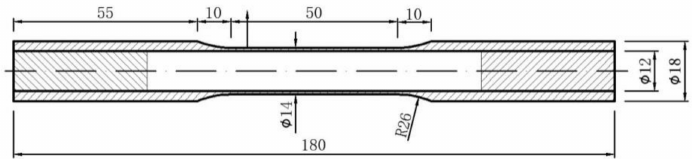
Figure 3. Geometries of the thin-walled tubular specimens used in the tests (mm).